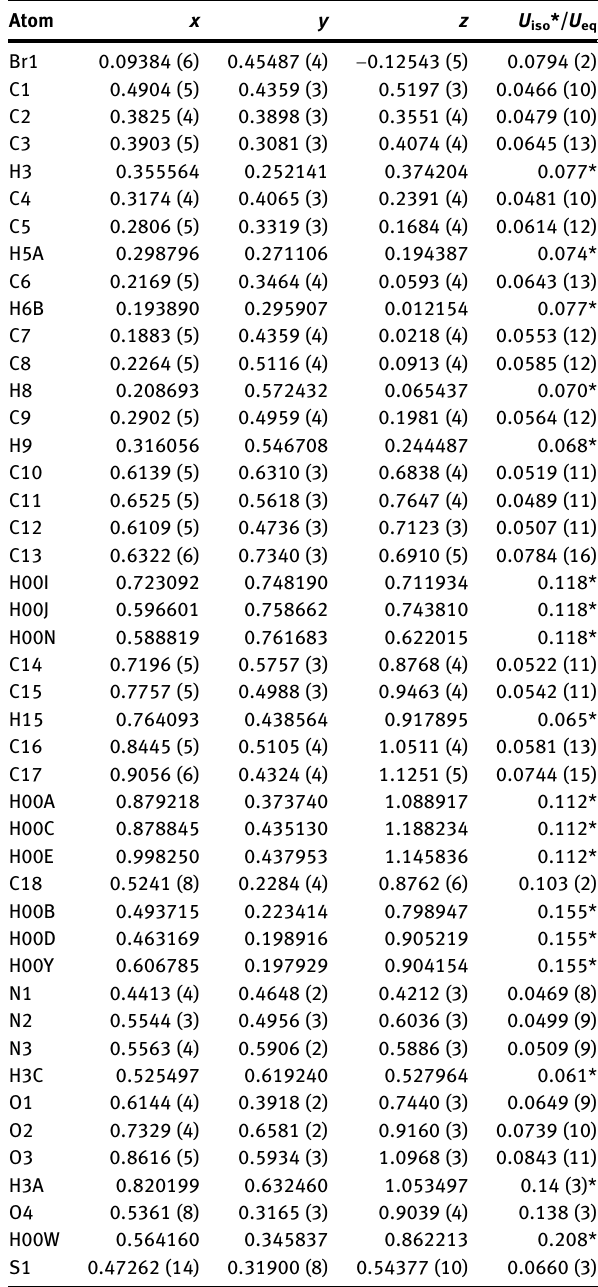
Table  : Fractional atomic coordinates and isotropic or equivalent isotropic displacement parameters (Å 